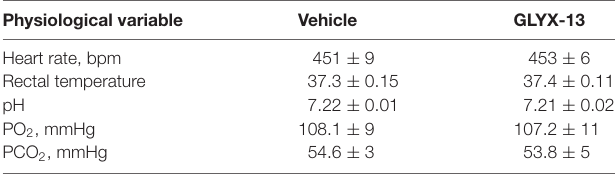
TABLE 1 | Physiological variables in control and GLYX-13 treated group.